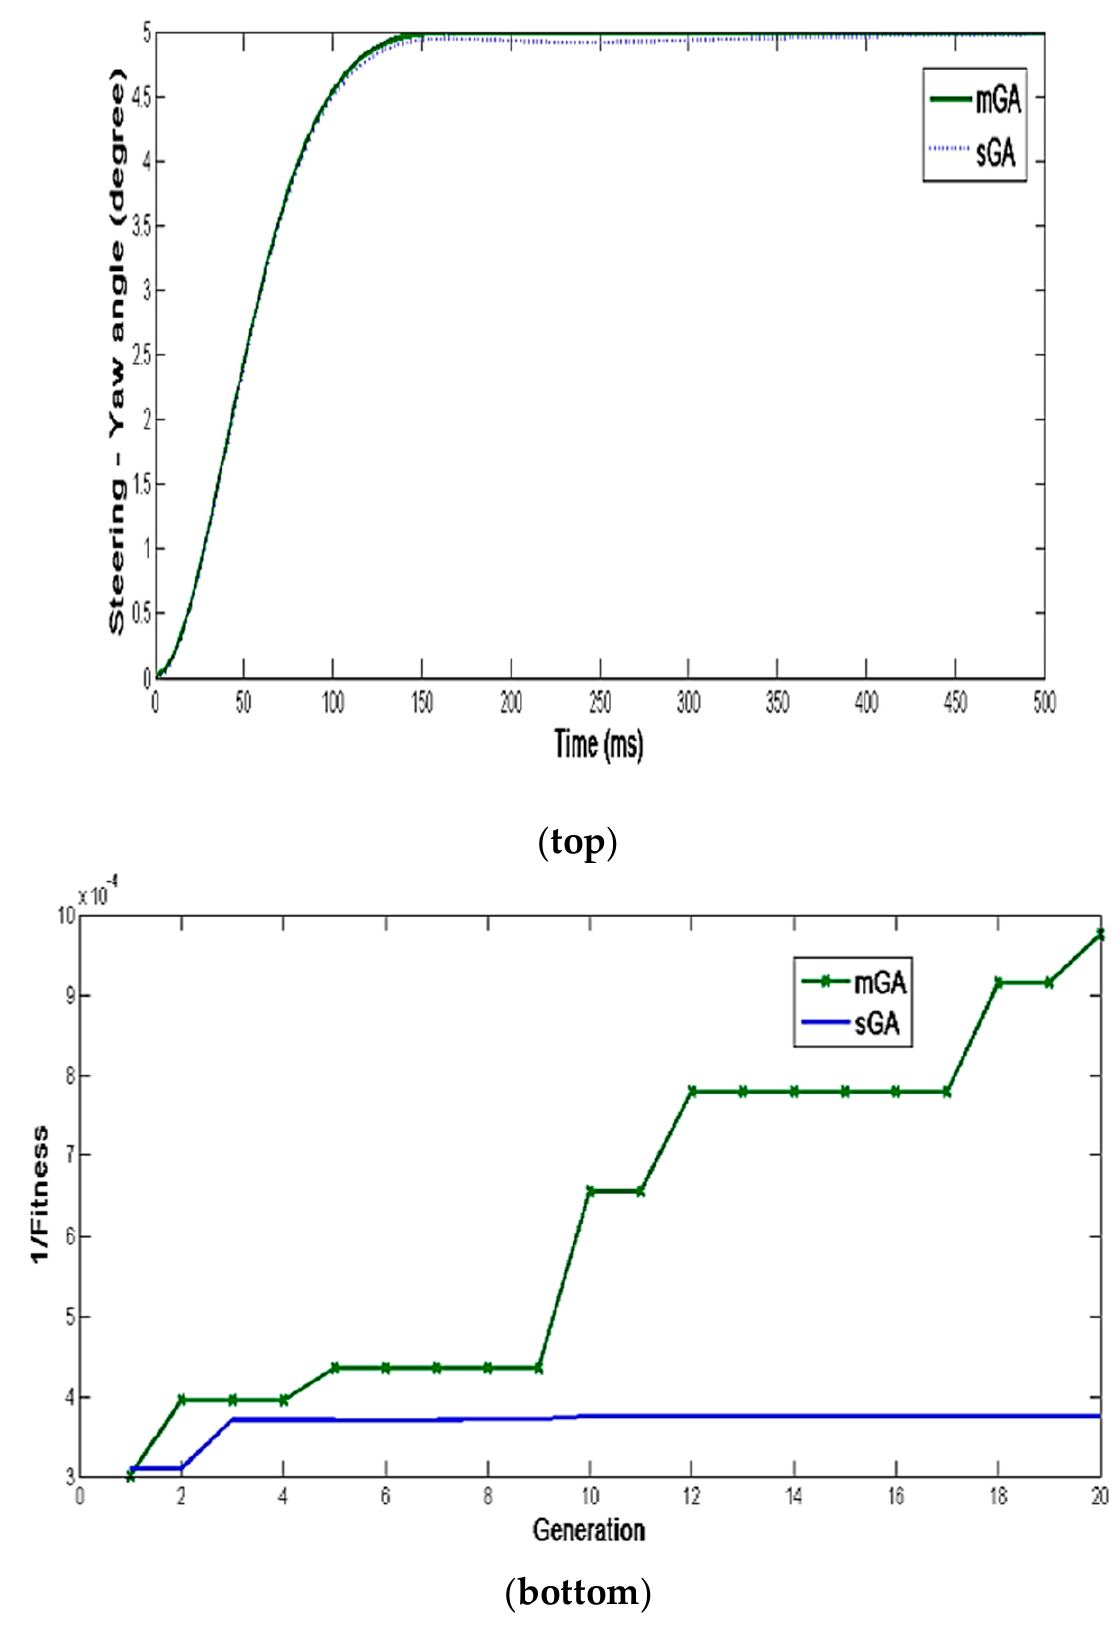
Figure 7. ( Top ) Steering—Yaw control; ( bottom ) improved GA (mGA) versus standard GA (sGA) fitness functions.